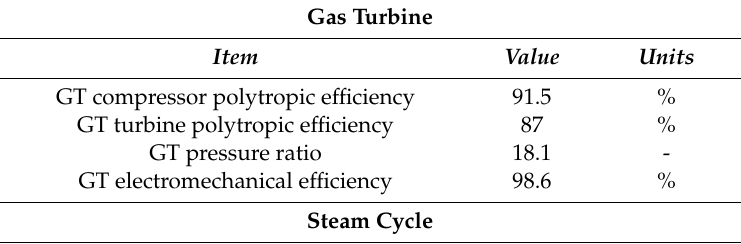
Table A3. Power cycle assumptions.